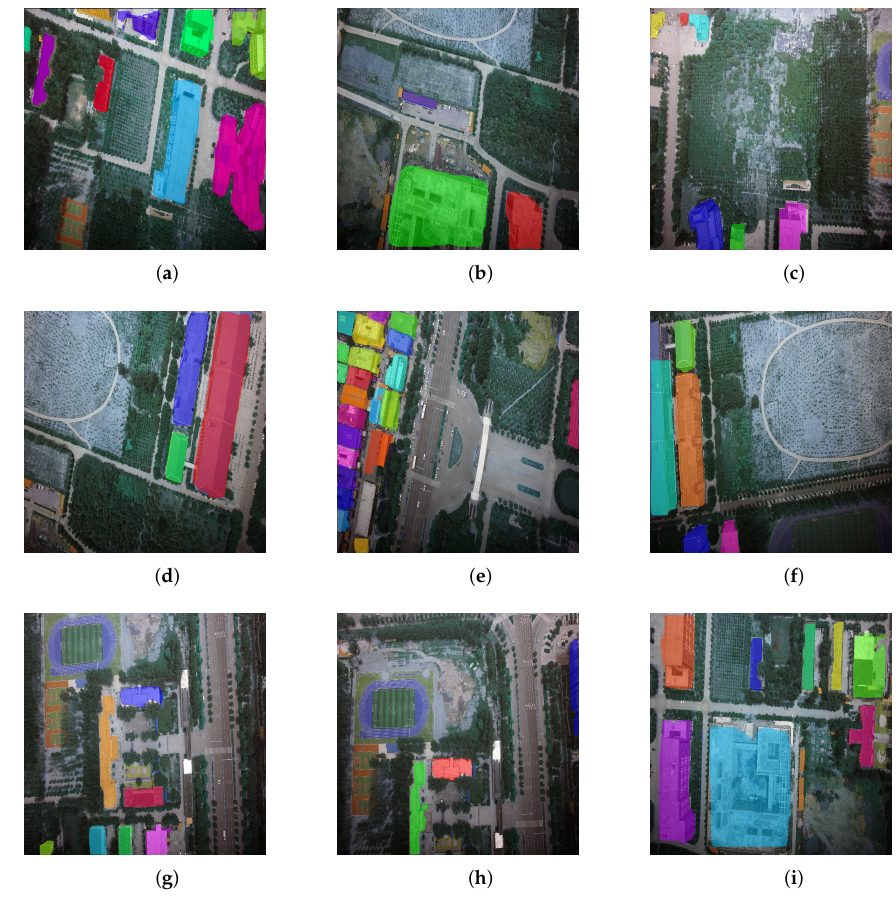
Figure 6. Visualization of the building predictions. According to the results of comparison between ground truth and predictions in grids as well as the visualization for building predictions, our method has achieved high